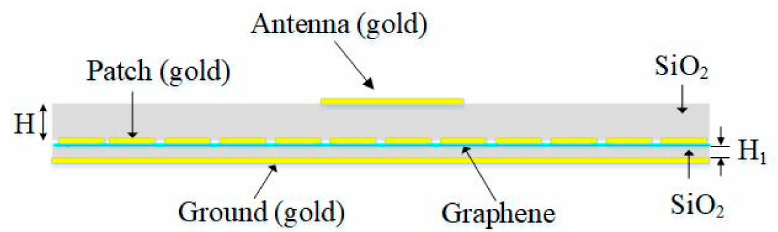
Figure 1. Side view of the loop antenna with the graphene-based high impedance surface (HIS).